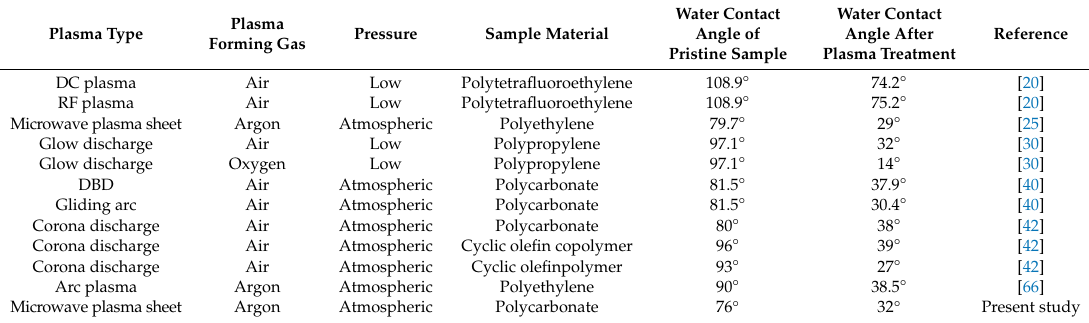
Table 1. Comparison of the water contact angle for di ff erent plasma-based methods of surface modification of polymeric materials.